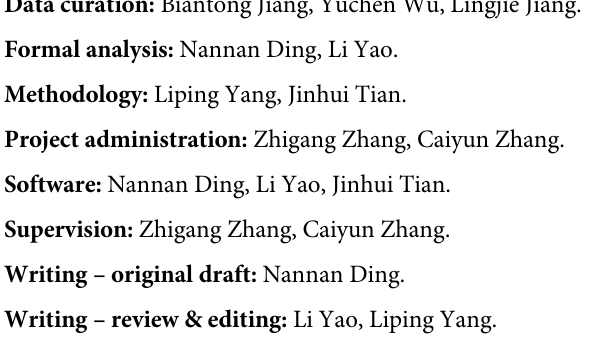
S2 Table. SUCRA and Meanrank results. SUCRA, surface under the cumulative ranking; ICU,Intensive care unit;—, not